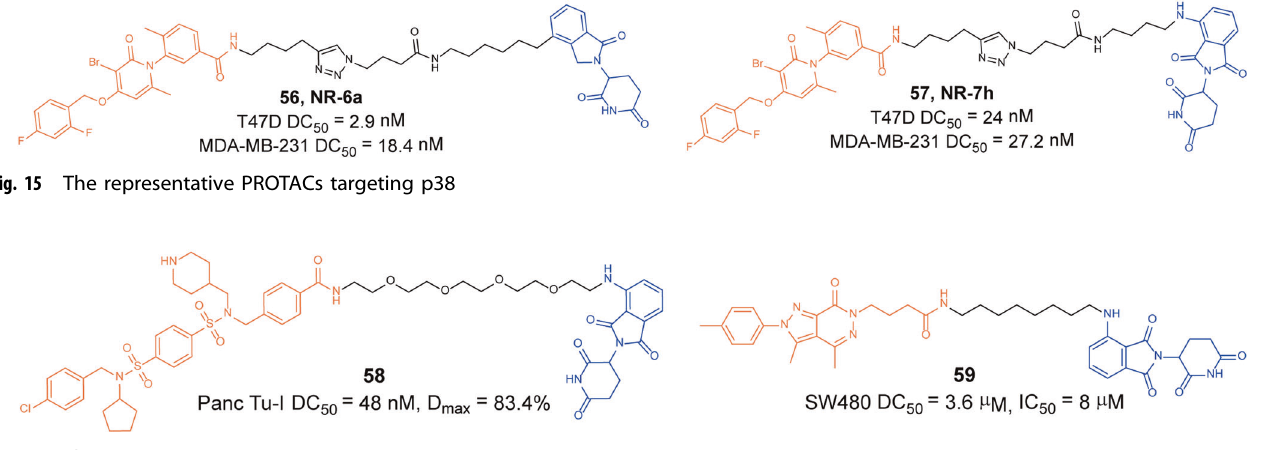
Fig. 16 The representative PROTACs targeting PDE δ